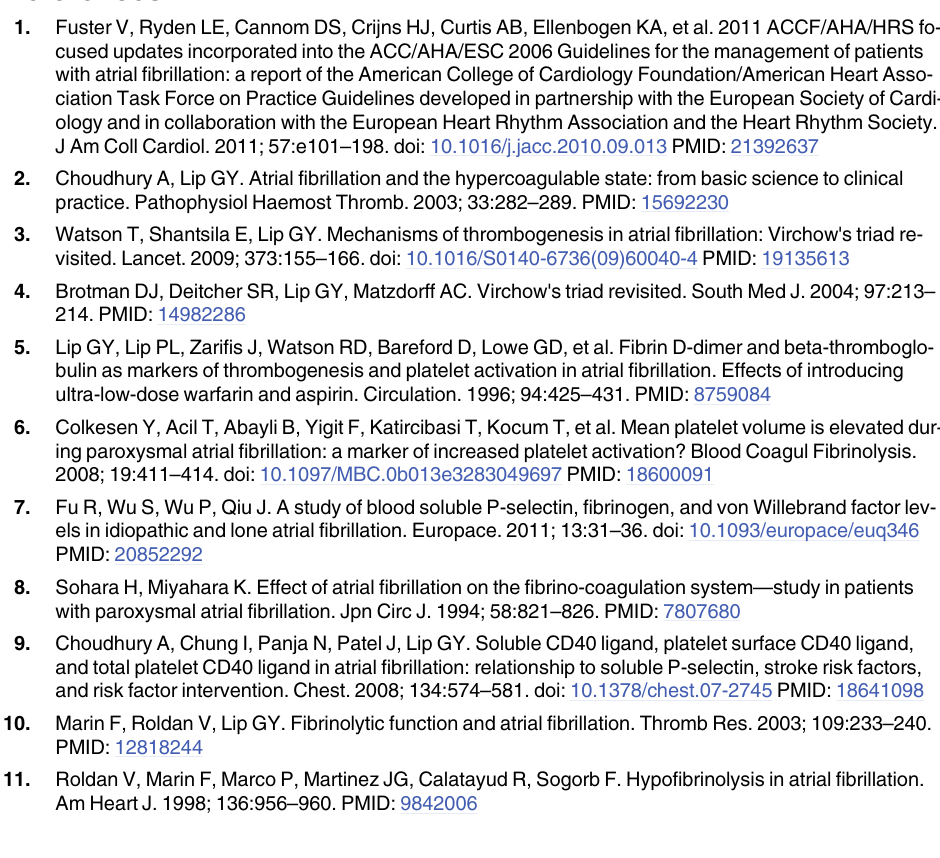
S1 Table. Quality assessment score scale. S2 Table. Characteristics of studies included for meta-analysis of association between hae- mostatic markers and AF. S3 Table. Univariate meta-regression results for haemostatic markers. S4 Table. Multivariate meta-regression results for fibrinogen and